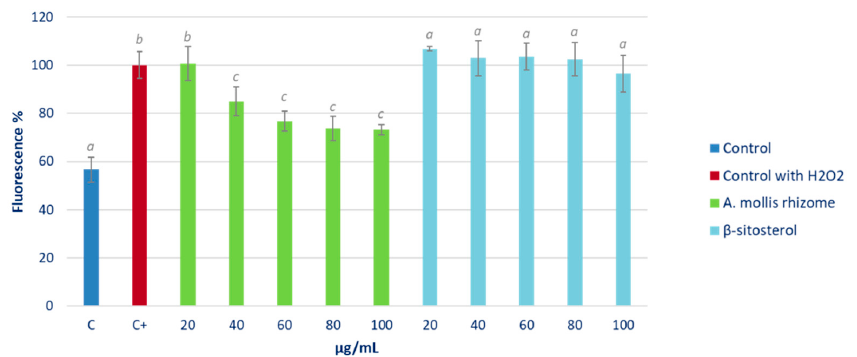
Figure 5. Effect of various concentrations of Acanthus rhizome extract and β -sitosterol on ROS levels in a HepG2 cell culture after 90 min of inducing oxidative stress with H 2 O 2 200 mM. Cells were pre-treated with 0 (control, C), 20, 40, 60, 80 and 100 µ g/mL of extract or reference substance for 24 h before inducing oxidative stress. Different letters indicate significant differences (ANOVA-Test, Bonferroni p <